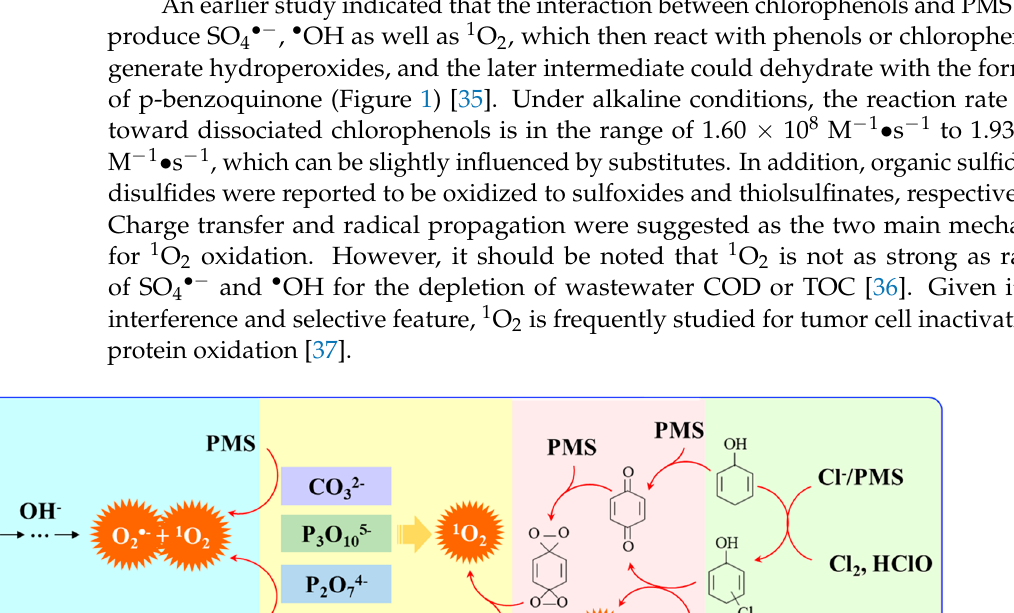
Figure 2. Evolution of 1 O 2 in homogeneous activation systems requiring different alkaline conditions.